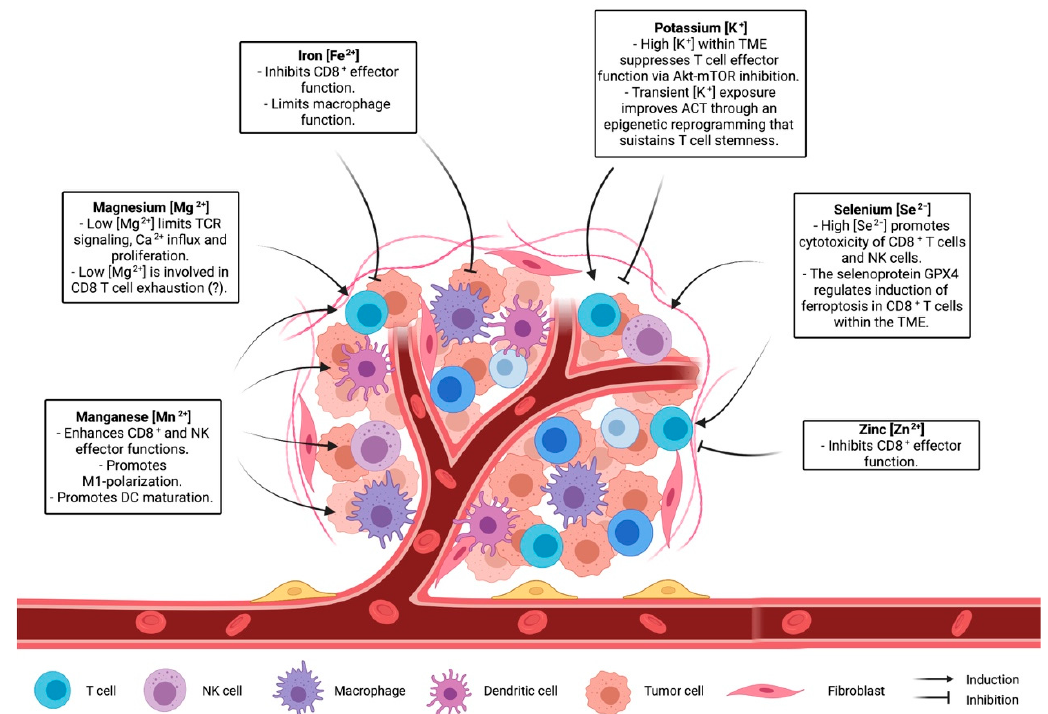
Figure 2. The role of ions in shaping the immune landscape of the microenvironment.